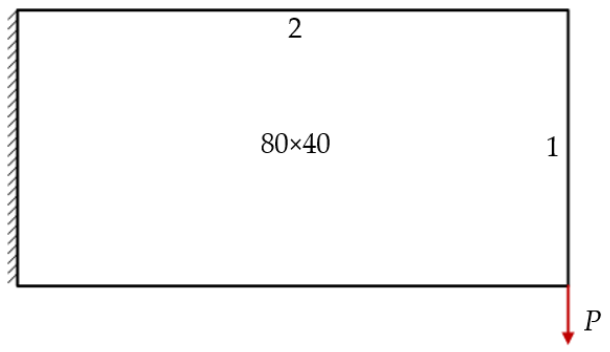
Figure 22. Design domain and boundary conditions of cantilever beam.